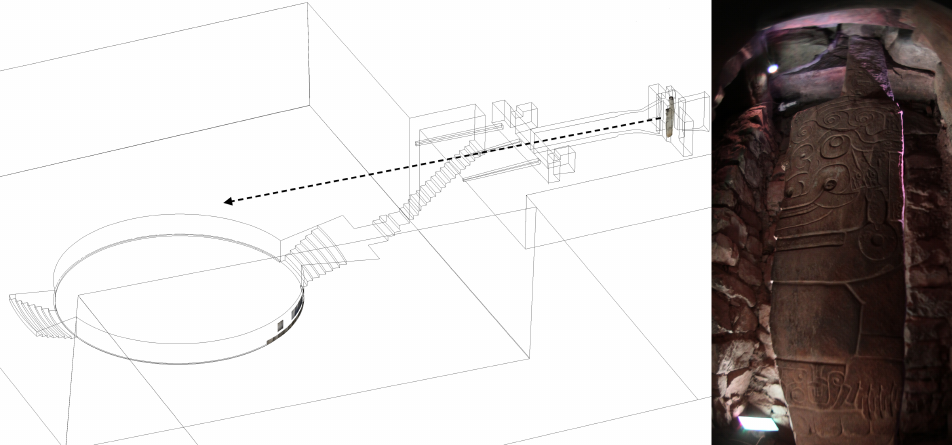
Figure 3. The Lanzón Gallery at Chavín de Huántar, Perú: geometrical model used in computational acoustical reconstructions ( left ) and photo of the Andean Formative granite monolith ( right ) also shown in its location at the western end of the stone-and-earthen gallery. Figure previously published in [16]; model and illustration by José L. Cruzado